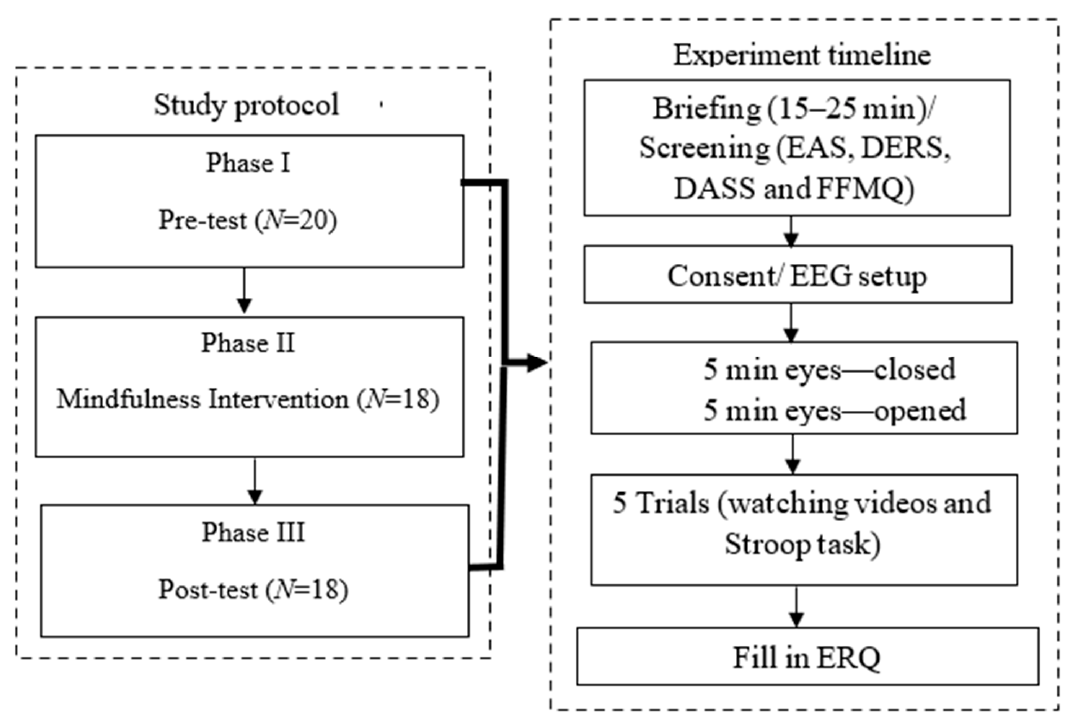
Figure 1. Flowchart of the study protocol and the experiment timeline .